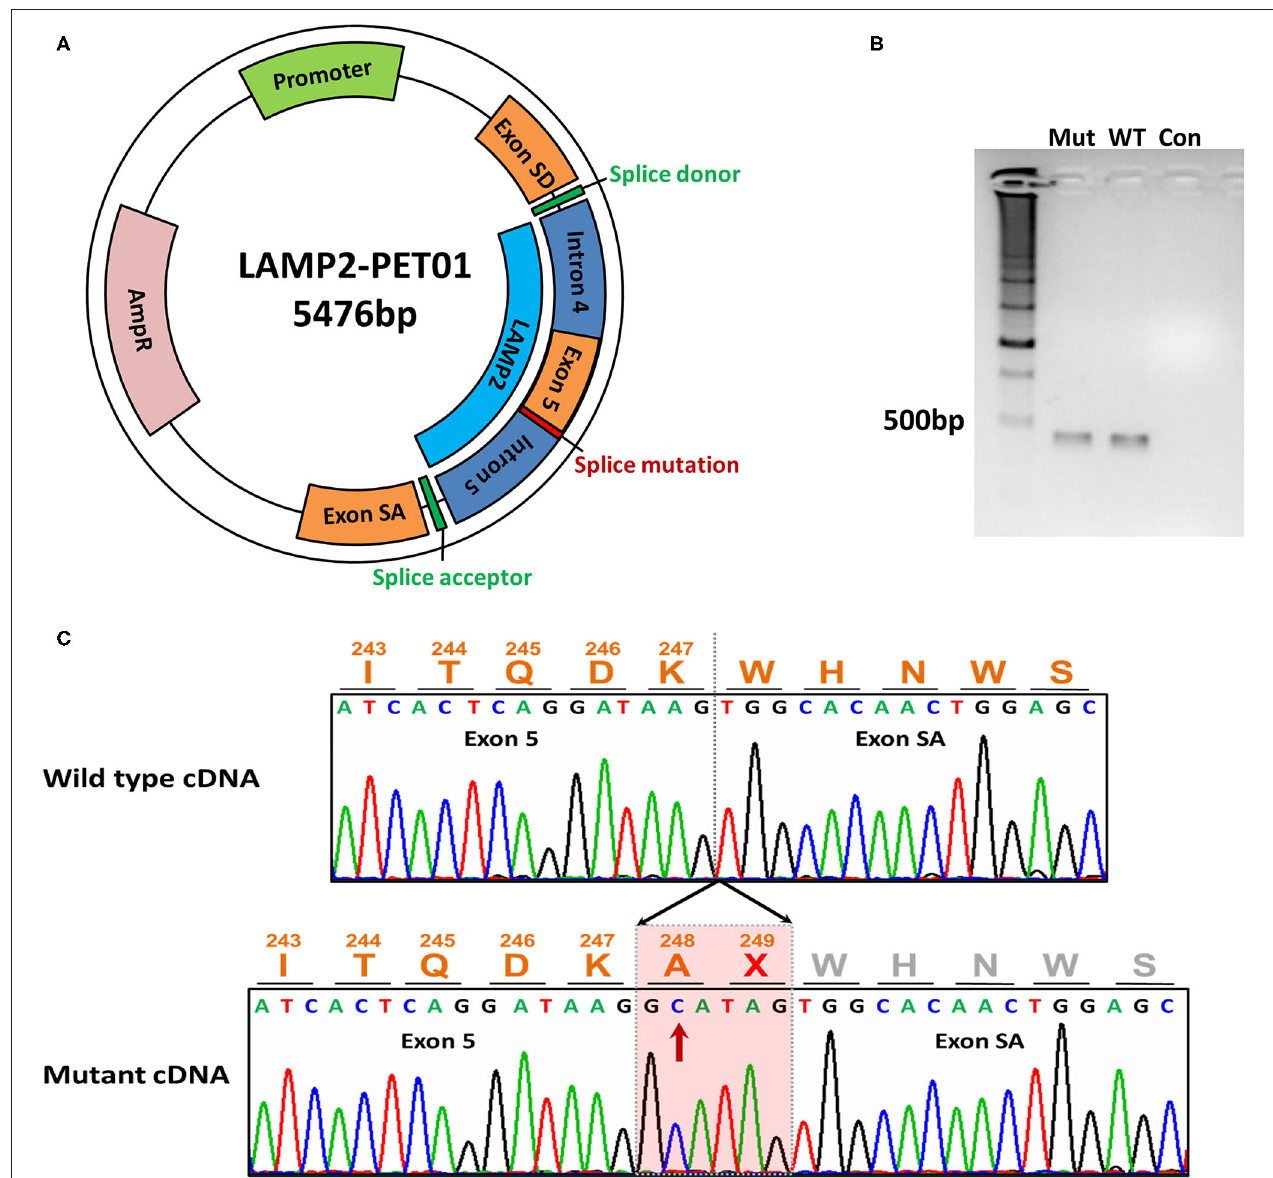
FIGURE 2 | The minigene assay of the mutation. (A) The construction of the LAMP2-PET01 minigene plasmid. (B) Electrophoresis of the cDNA products. Total RNA was extracted after 48h the minigene plasmid was transfected and reverse transcribed into cDNA. Mut represents cDNA from mutant plasmid treated. WT represents cDNA from wild-type plasmid treated. Con, represents blank control without any cDNA. (C) Sanger sequencing of the cDNA products. Sequencing identified extra 6-bp preservation of intron 5 at the junction between exons 5 and exon SA during transcriptional processing of the mRNA, which creates a stop